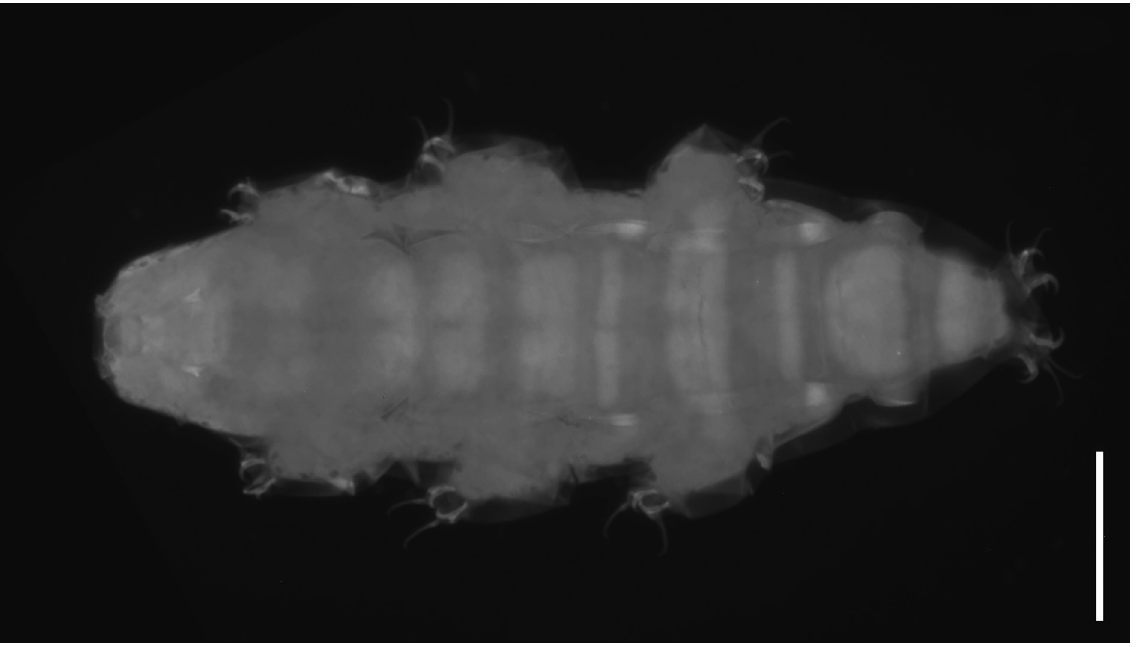
Fig. 4. Milnesium pelufforum sp. nov., paratype, young (slide No. UNLPam 389-1) under UV fluorescence microscope, showing various pseudoplates. Scale bar = 50